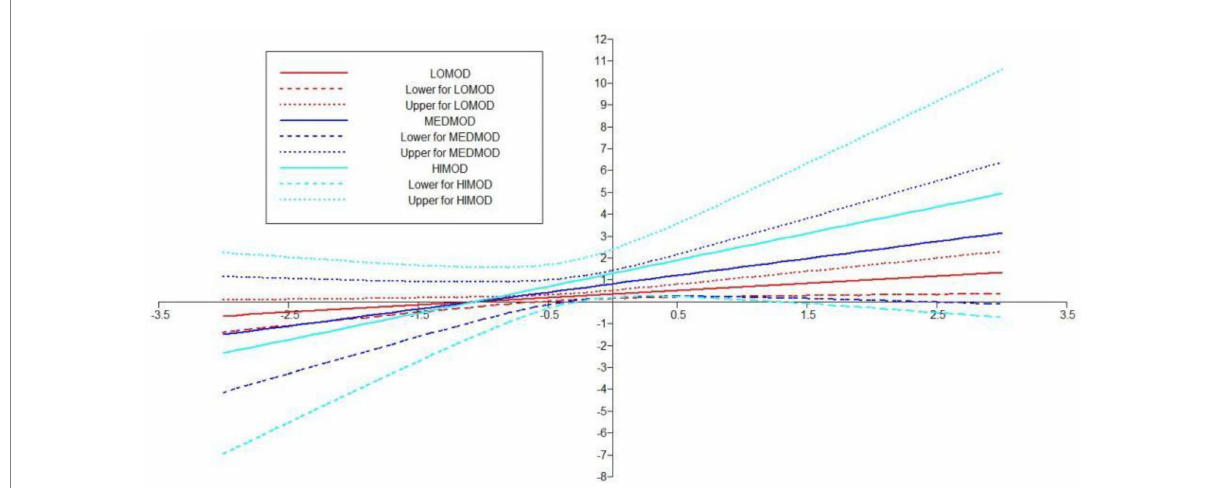
FIGURE 7 Interaction plott showing the moderating effect of PSS on FS—MH relationship.